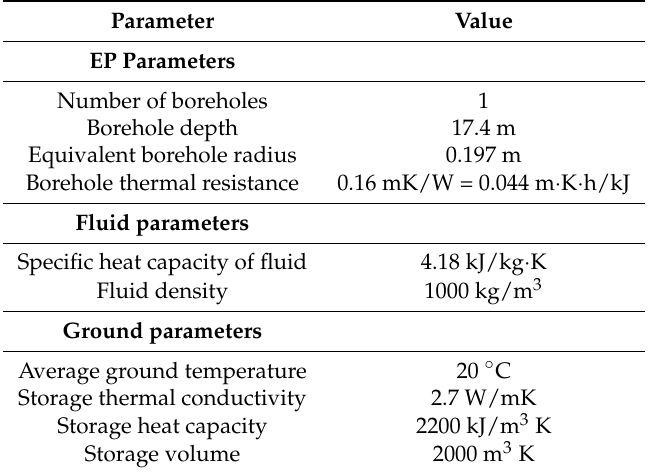
Figure 6. TRNSYS characterization model. Table 3. Description parameters of the